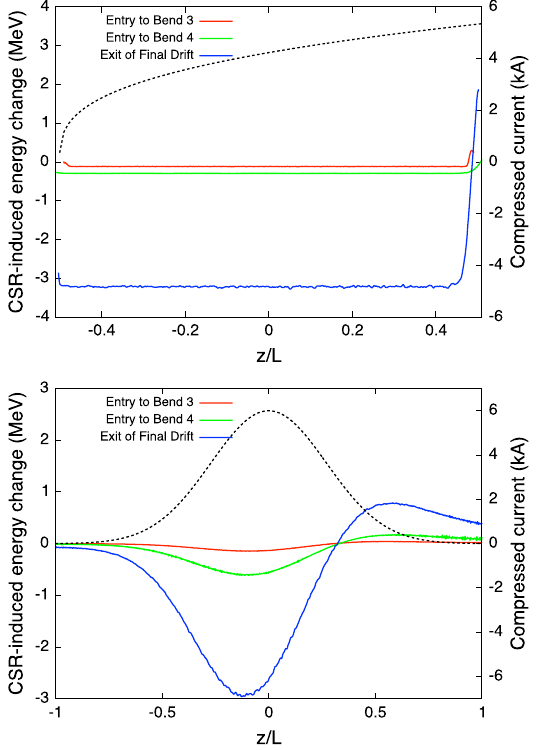
FIG. 8. (Top) The difference in mean slice energy in the presence and absence of CSR for the density given in (15). The result is shown at the entry to Bend 3 (red), the entry to Bend 4 (green), and the exit of the system (blue). The final compressed current profile is shown for reference (dashed). (Bottom) The difference in mean slice energy in the presence and absence of CSR for a Gaussian density with the same second moments.